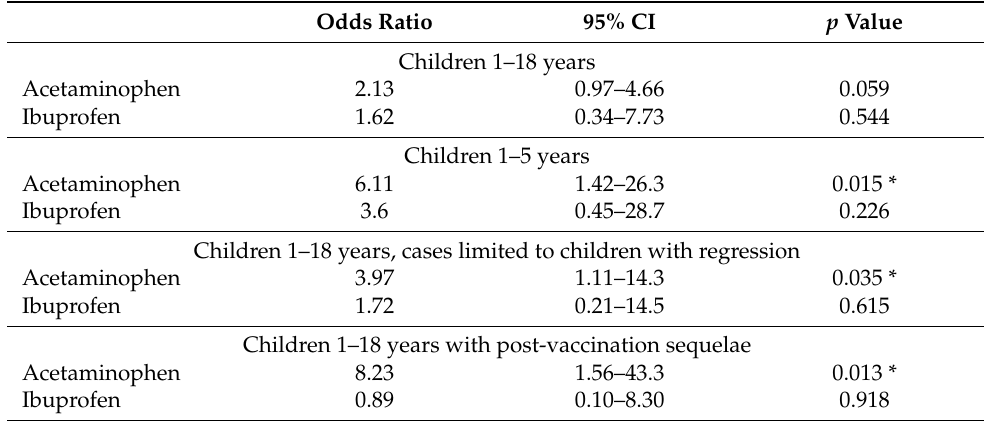
Table 2. Association of analgesic use and ASD. * indicates statistical significance ( p < 0.05). Adapted from [3].